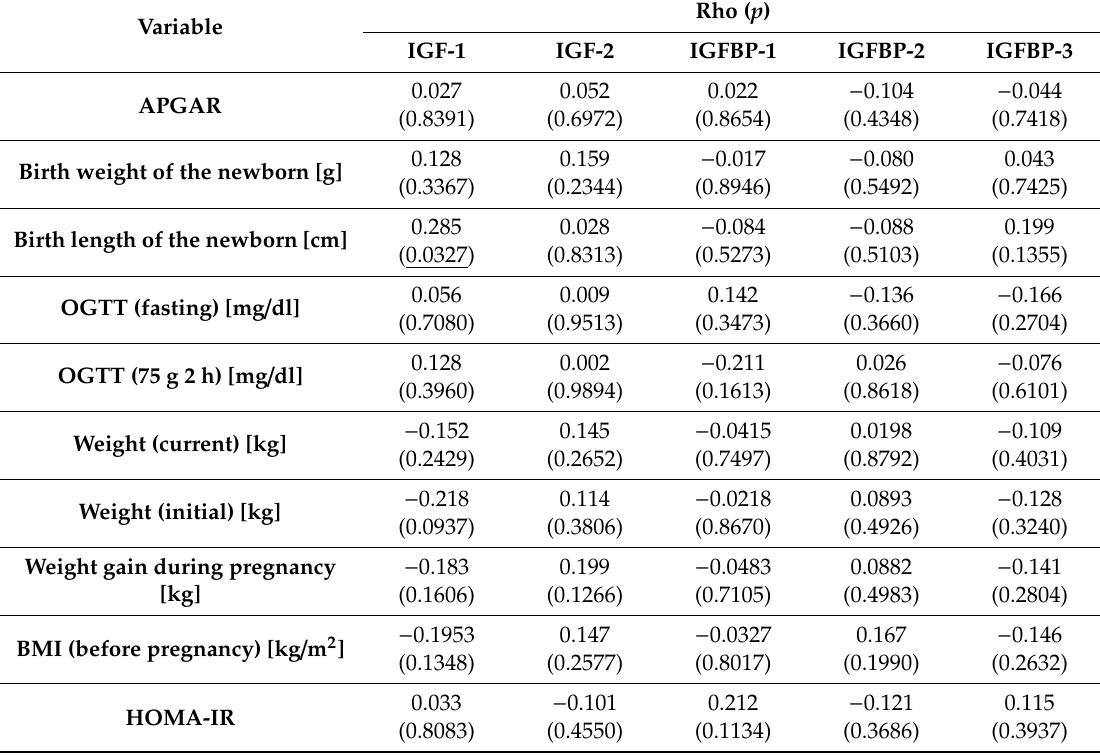
Table 4. Spearman’s correlation between cord blood plasma (IGF-1, IGF-2, IGFBP-1, IGFBP-2, IGFBP-3) concentrations (ng / mL) and clinical / biochemical parameters in the GDM group.